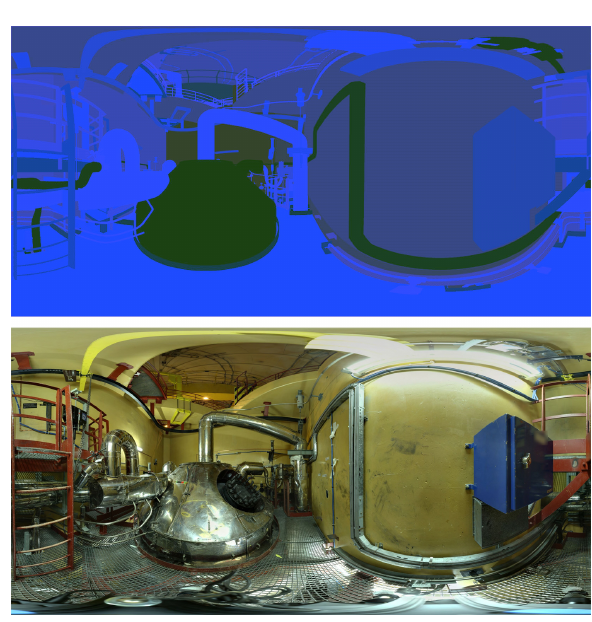
Figure 4. Label generation using an unlit rendering of a 3D model (top) where object class is encoded in the R channel and object ID in the G and B channels at the exact position and orientation of a panoramic image